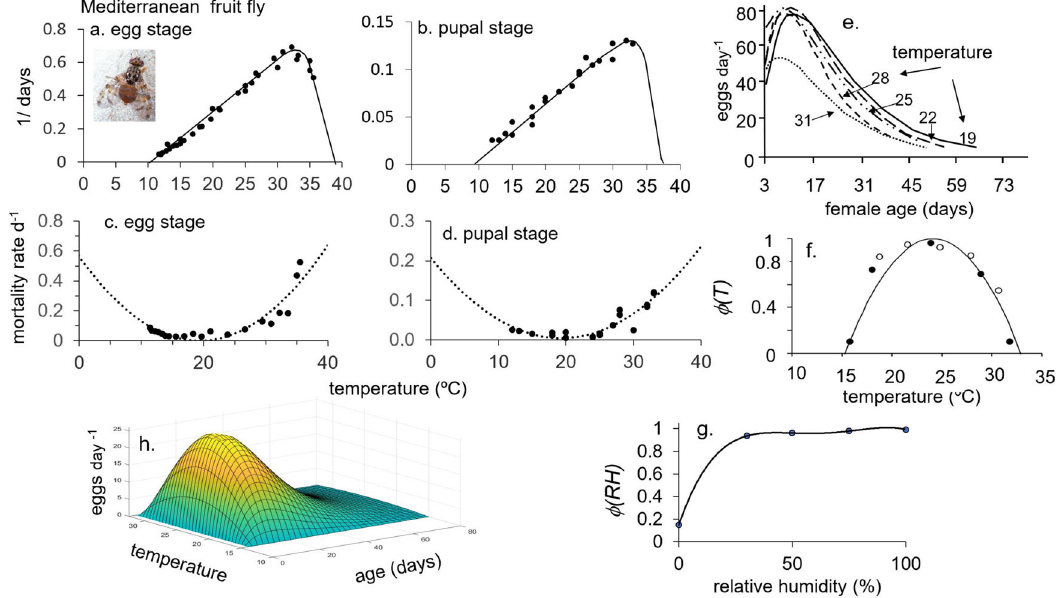
Fig. 5 Biodemographic functions for Mediterranean fruit fl y. a , b Rates of development of the egg 75,81 and pupal stages respectively, c , d mortality rates for egg and pupal stages respectively 43,51,75,76,78,79,81,82 , e per capita fecundity pro fi les on age in days at different temperatures 77,83 , f , g temperature ( ϕ (T) ) 84 and relative humidity ( ϕ (RH) ) 85 scalars for adult reproduction, and h 3-D age speci fi c fecundity pro fi les corrected for the effects of ϕ (T) . The clip of Mediterranean fruit fl y is by Jack Kelly Clark, University of California Statewide IPM